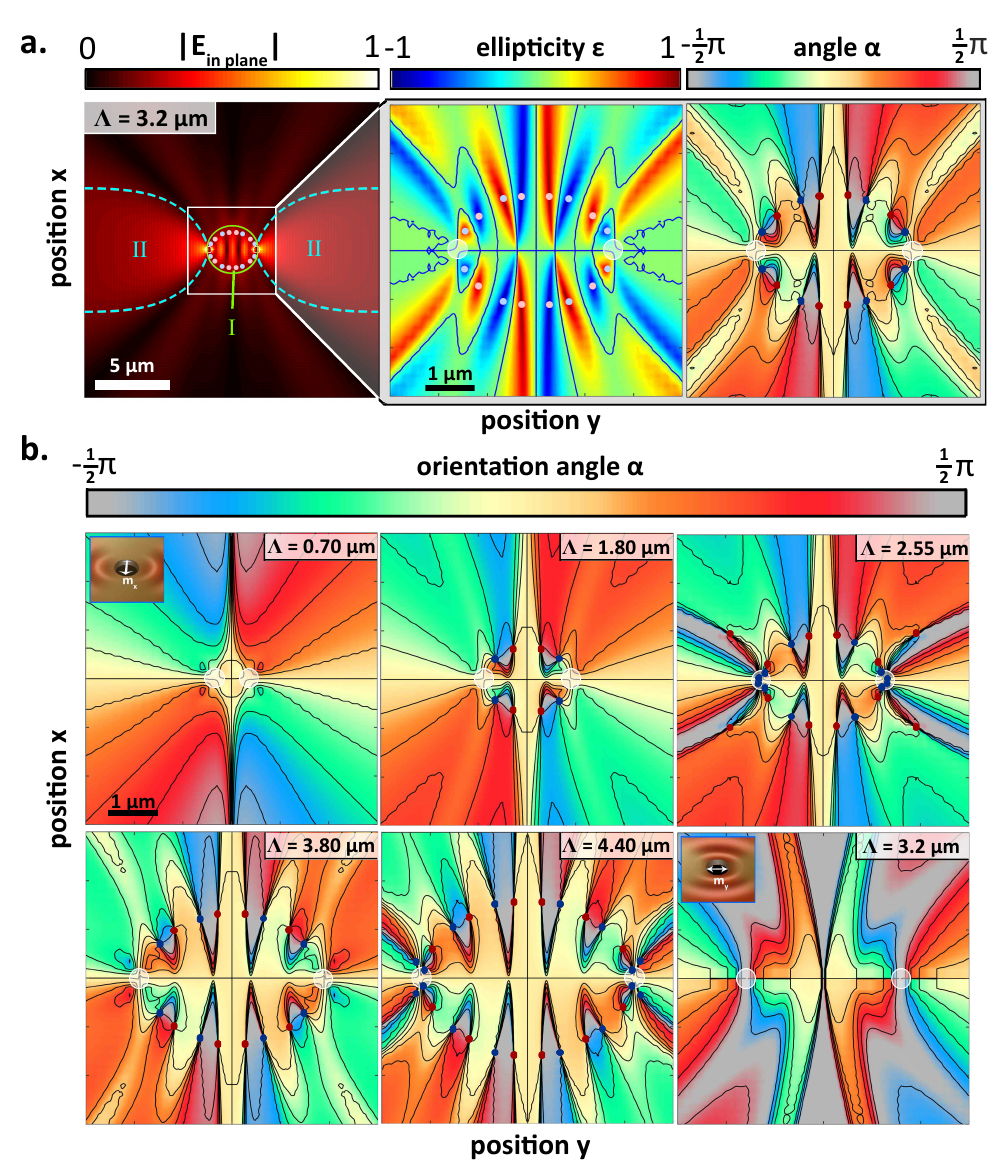
Figure 2. Light field maps for different plasmonic systems. ( a ) The in-plane electric field amplitude map, along with zoomed in maps of the ellipticity and orientation of the polarization ellipse, for two holes separated by 3.2 µ m, with initial excitation H field amplitude map, we show two curves, ( I ) an ellipse and ( II ) two parabolas, along which we find polarization singularities. In this figure, we see C-points along I only, and we color code them according to their topological charge, with blue being +1 / 2 and red − 1 / 2 . We also present ε and α maps in a smaller region of the central area around the holes. For ε , we mark the linear (L)-lines with solid curves, while for α , we likewise show the isogyres. ( b ) α maps, with circular (C)-points marked in solid symbols as in (a), for Λ ranging from 0.70 µ m, where we see no C-points, to 4.40 µ m, where we see 28 C-points (24 on I and four on II ) in our field of view. The last frame shows the case of Λ = 3 . 2 µ m for H